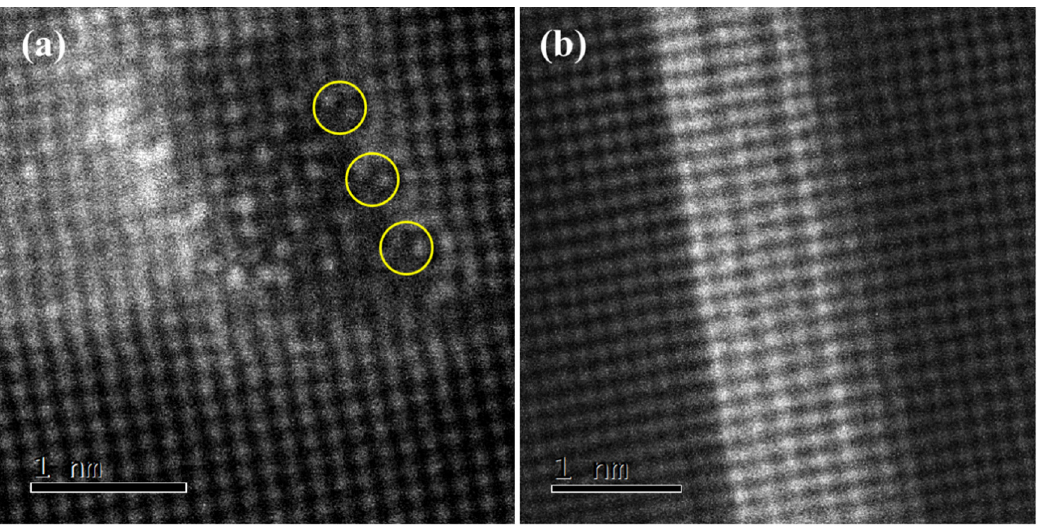
Figure 8. HAADF-STEM images of the precipitate after aging for 12 h. [ 100 ] Al ( a ) type I GP zone; ( b ) type II GP zone.